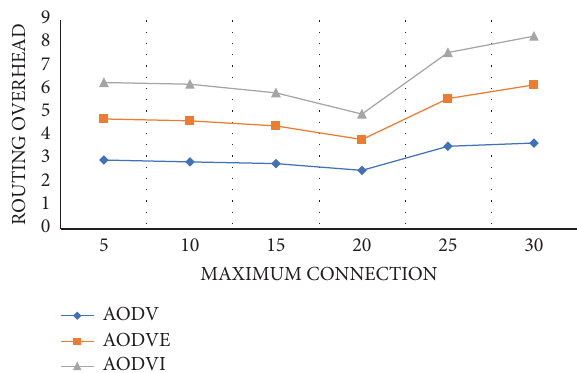
Figure 10: Maximum connection vs routing overhead.